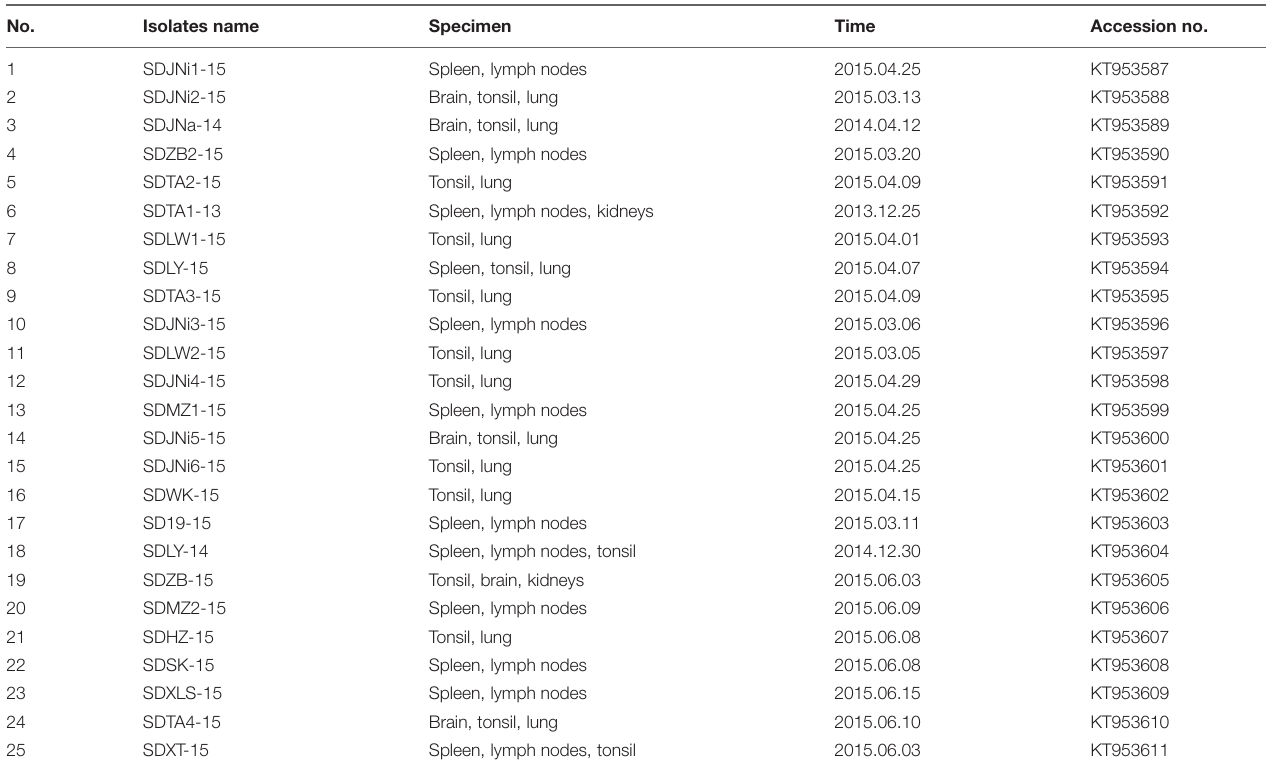
TABLE 1 | Characteristics of the 25 new isolates and GenBank accession no. of E2 genes (1,119